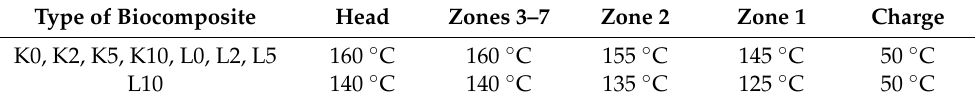
Figure 2. Areas on the individual heating zones of the twin screw extruder for K0 biocomposite extrusion. Table 1. The temperatures set on the individual heating zones of the twin screw